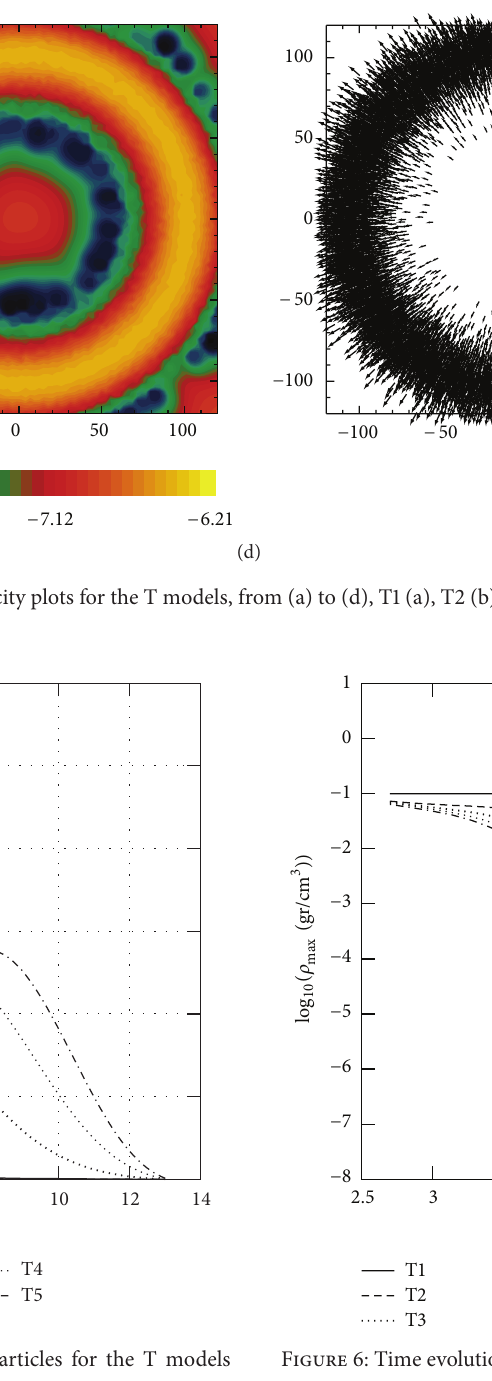
where 𝛾 = 5/3 and the critical density 𝜌 10 −14 g cm −3 ; 𝑐 0 , the sound speed, is given by 16647.83 cm s −1 , so that the corresponding temperature asso- ciated with the core is 𝑇 ≈ 10